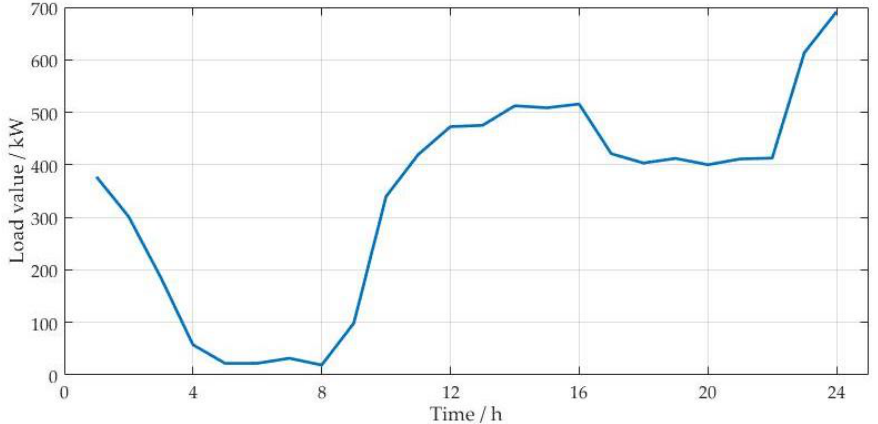
Figure 1. Typical daily load curve of an e-bus charging station in Baoding. The load is influenced by various factors.